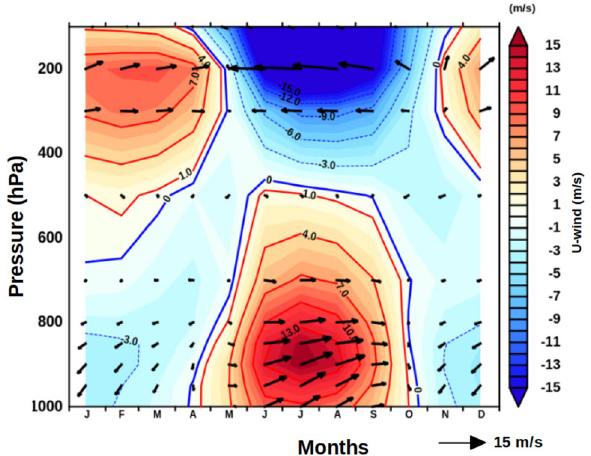
Figure 2. Vertical structure of monthly mean climatology of zonal wind (u-wind, m/s) averaged over the longitude 60°E to 70°E and latitude 6°N to 20°N overlaid with wind vectors.